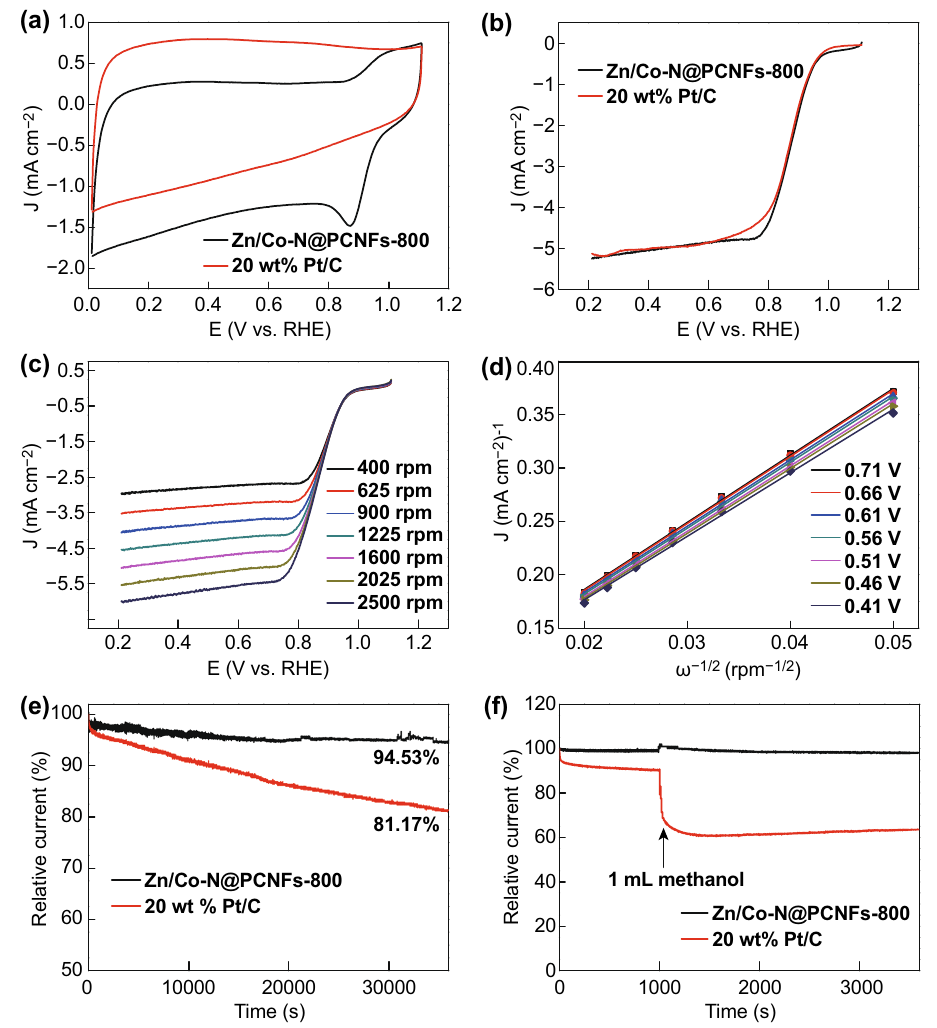
Fig. 8 a CV curves of Zn/Co–N@PCNFs-800 in 0.1 M N 2 -saturated and O 2 -saturated KOH with a sweep rate of 50 mV s −1 . b LSV curves for Zn/Co–N@PCNFs-800 and 20 wt% Pt/C in 0.1-M O 2 -saturated KOH electrolyte with a 10 mV s −1 and a rotation rate of 1600 rpm. c LSV curves of Zn/Co–N@PCNFs-800 at different rotation speeds from 400 to 2500 rpm. d K – L plots of Zn/Co–N@PCNFs-800 at different poten- tials. e Chronoamperometric response of Zn/Co–N@PCNFs-800 and 20 wt% Pt/C in 0.1 M O 2 -saturated KOH aqueous solution at 0.71 V versus